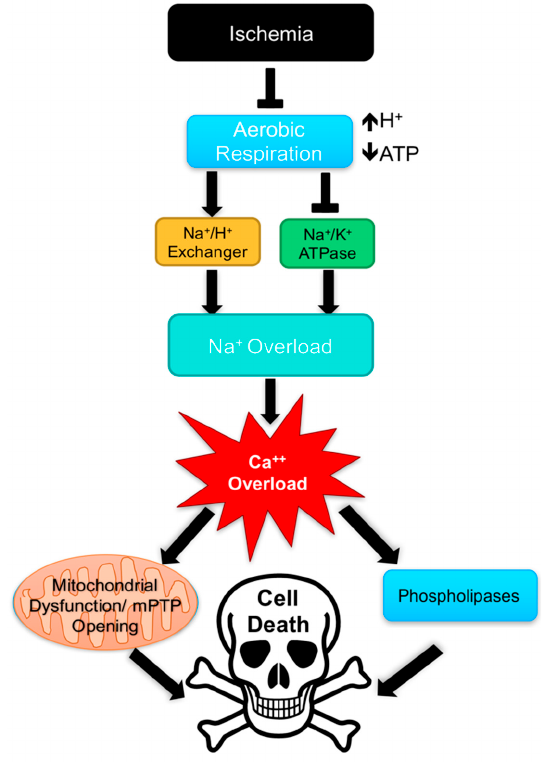
Figure 3. Overview of mechanisms contributing to cell death following ischemia. Ischemia results in ion channel dysfunction following decreased production of ATP and increased hydrogen ion (H+) production leading to cellular acidosis. Ultimately excessive intracellular calcium (Ca 2+ ) triggers activation of phospholipases and the opening of the mitochondrial permeability transition pore (mPTP) in turn inducing cell death.